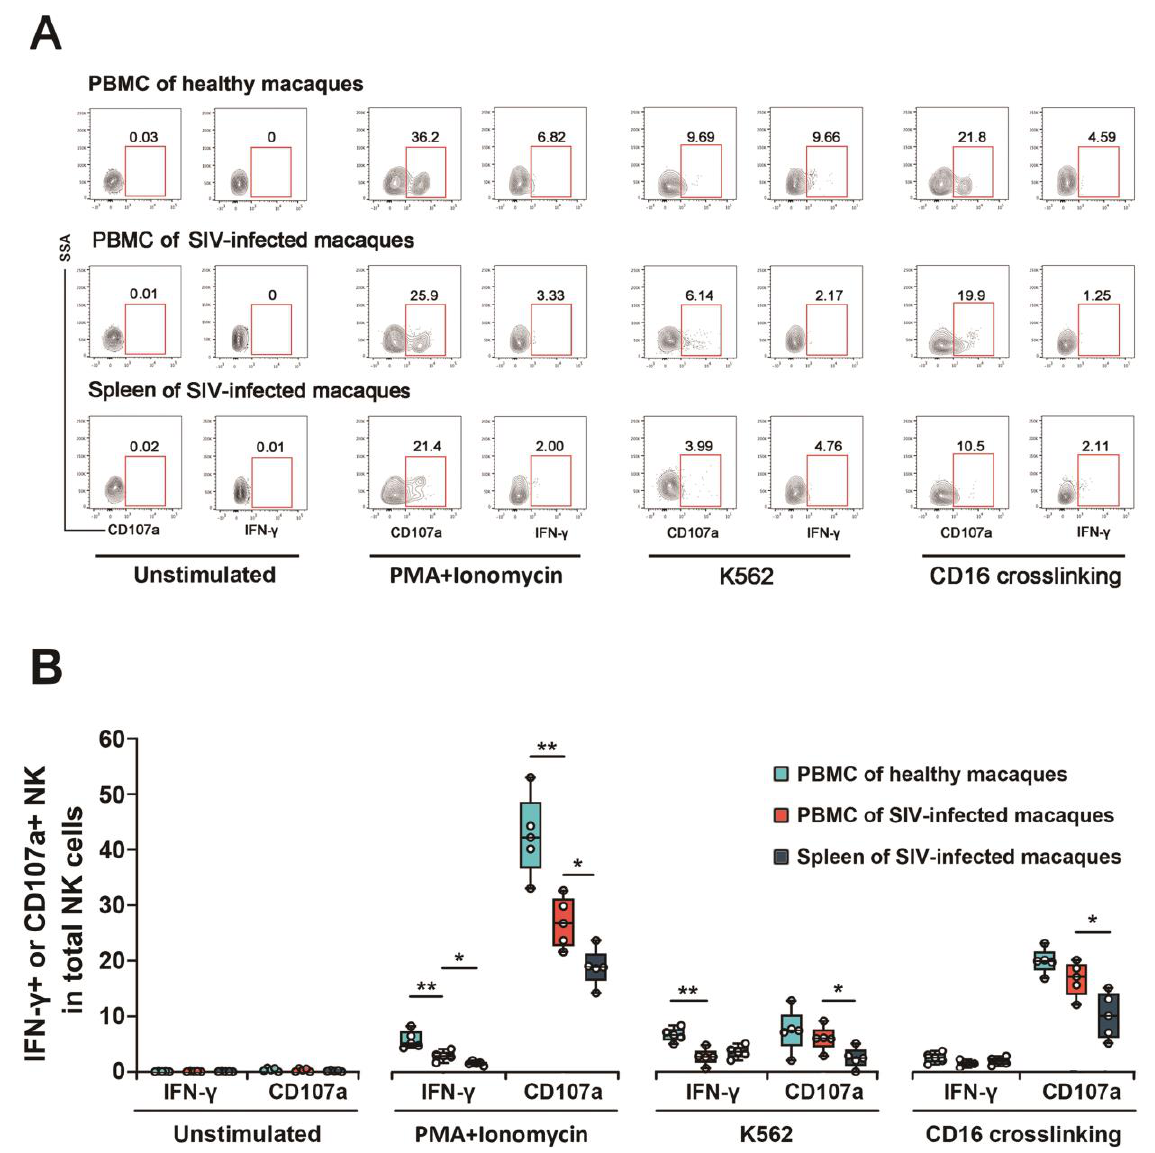
Figure 4. Functional activity of NK cells from simian PBMCs and splenic single-cell suspension. ( A ) Lymphocytes were isolated from the peripheral blood (healthy and SIV-infected macaques) and the splenic single-cell suspension (SIV-infected macaques only) and were stimulated with PMA and ionomycin, K562 cells, and CD16 cross-linking. IFN- γ production and CD107a expression by NK cells were shown. ( B ) The frequencies of IFN- γ + and CD107a + NK cells among total NK cells. “*” indicates significant differences by Mann – Whitney U test (*, p < 0.05; **, p < 0.01). PBMC — peripheral blood mononuclear cell; PaLN — paracolonic lymph node; ALN — axillary lymph node.